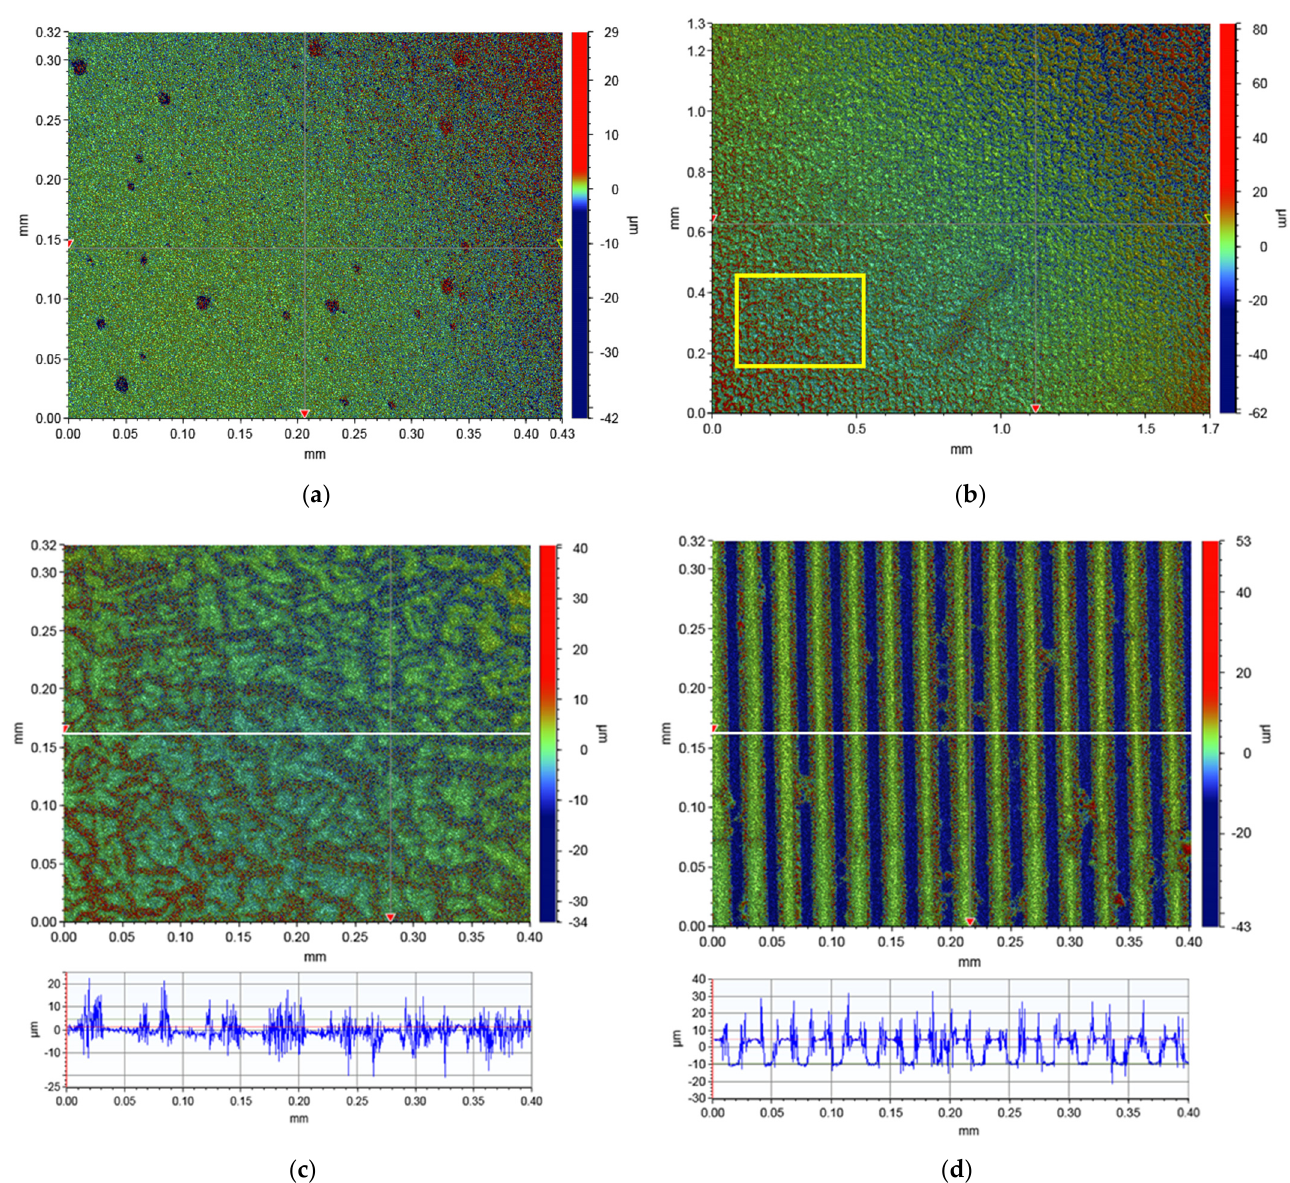
Figure 6. Optical profilometry images of ( a ) the surface of sample M1 before embossing in B = 0 and ( b , c ) after embossing in B = 180 mT. ( d ) Optical profilometry image of the stamp used for embossing. Graphs at the bottom of ( c , d ) are cross-sections along the white lines depicted in topographical images. Yellow square in ( b ) indicates the relative size of the surface areas shown in images ( a , c , d